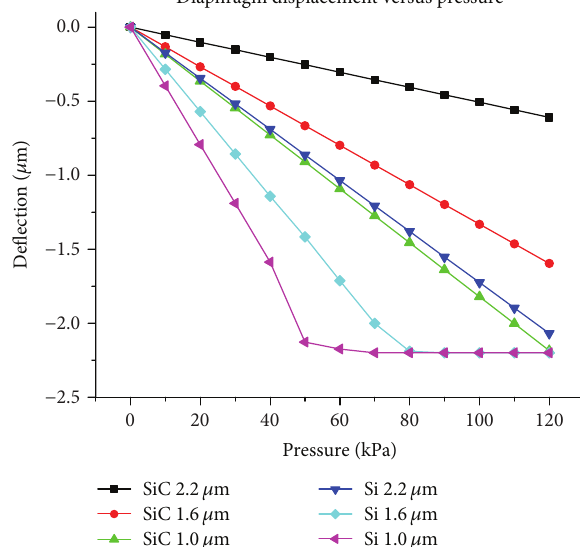
Figure 8: Comparison of deflection versus pressure for 3C-SiC and Si with differential thicknesses of